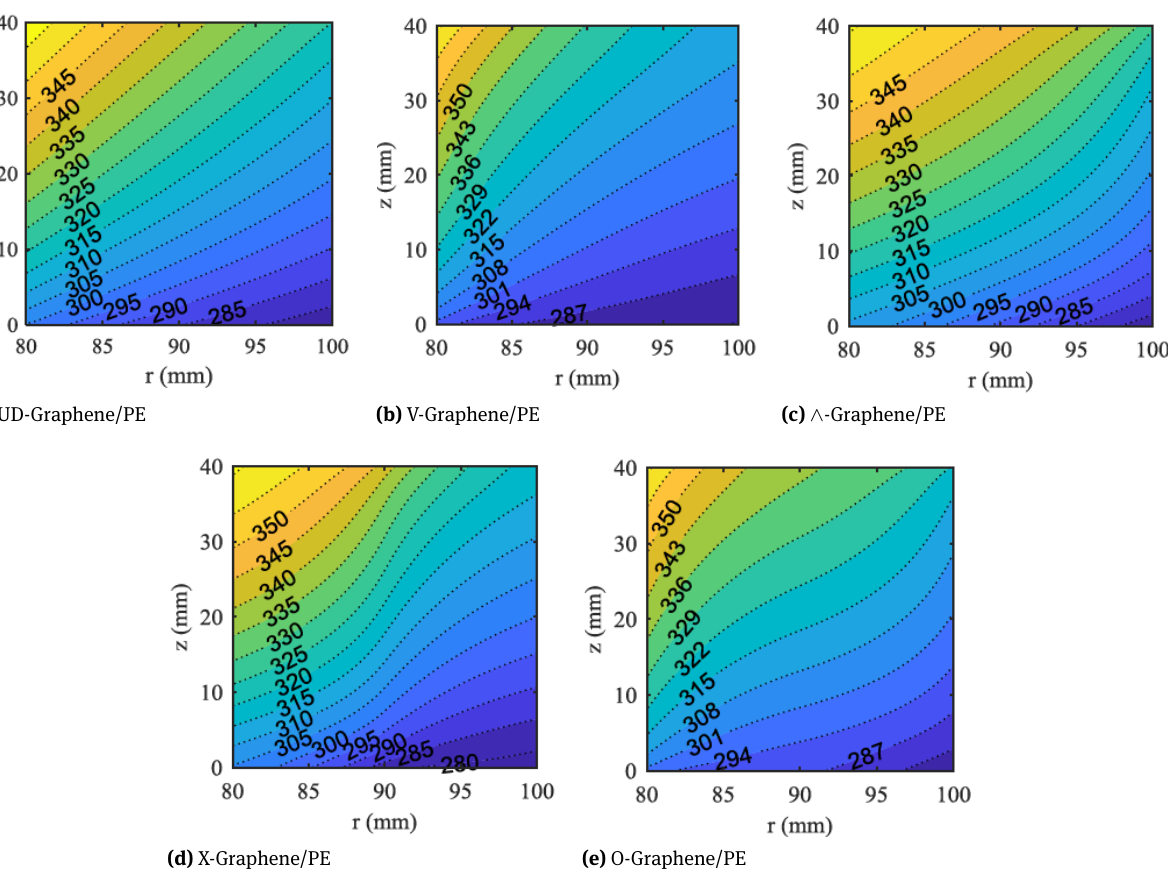
Figure 8: Two-dimensional temperature (K) profiles a) UD, b) V, c) ∧ , d) X and e) O-graphene/PE cylinders subjected to inner and upper heat fluxes, and outer and lower cold convection